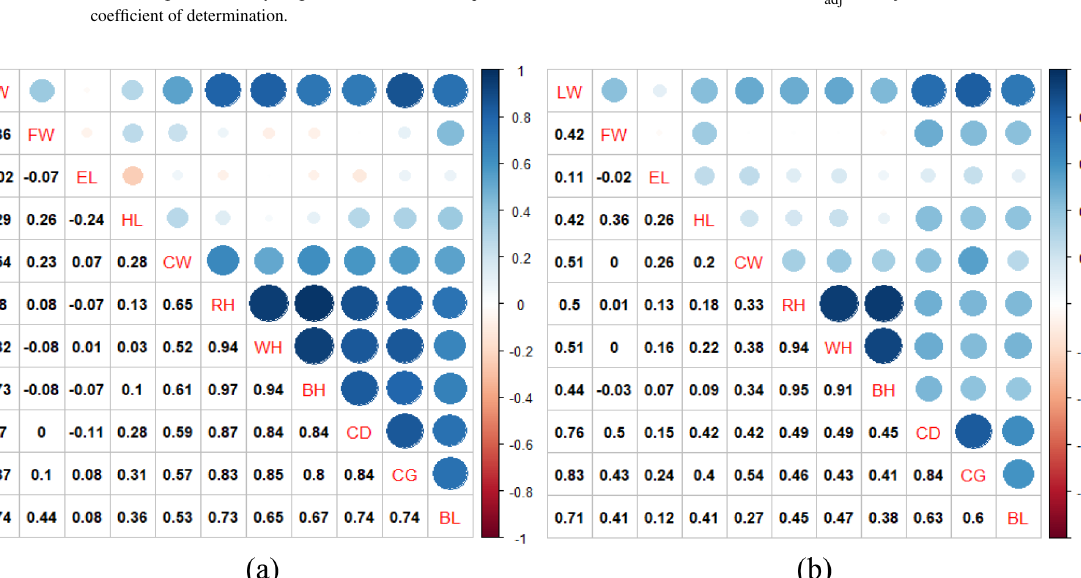
shown in Table 2, there were VIF values of more than